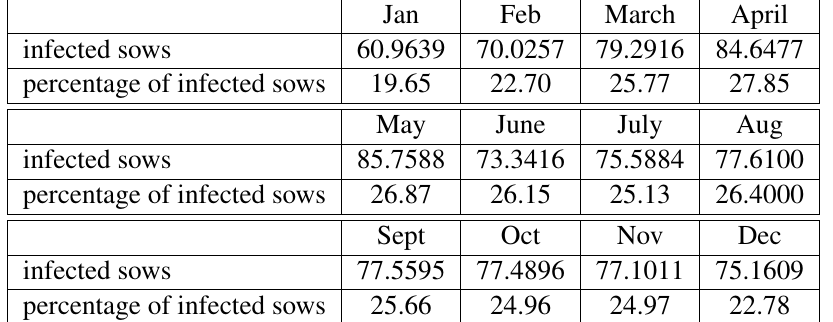
Table 3 Simulation of monthly percentages of infected